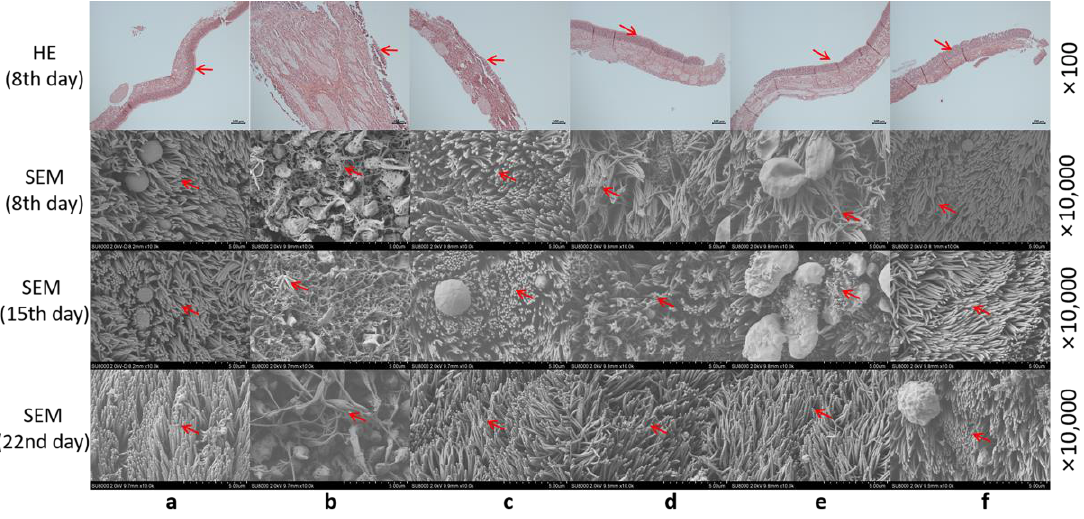
Figure 6. Morphology of the nasal mucosa of the rats in each group. ( a ) Normal group; ( b ) positive control group; ( c ) low-dose group; ( d ) middle-dose group; ( e ) high-dose group; ( f ) a- β -CD group.